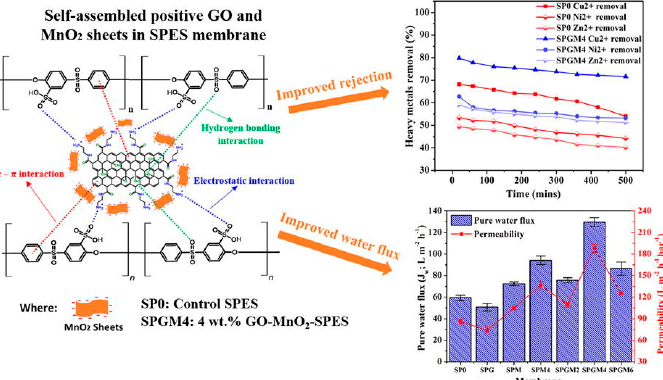
Figure 29. Performance of SPES-GO-MnO 2 composite UF membranes for wastewater treatment applications [302] Reproduced with permission from Ibrahim, Y.; Wadi, V.S.; Ouda, M.; Naddeo, V.; Banat, F.; Hasan, S.W, Chemical Engineering Journal; published by Elsevier B.V., 2022.